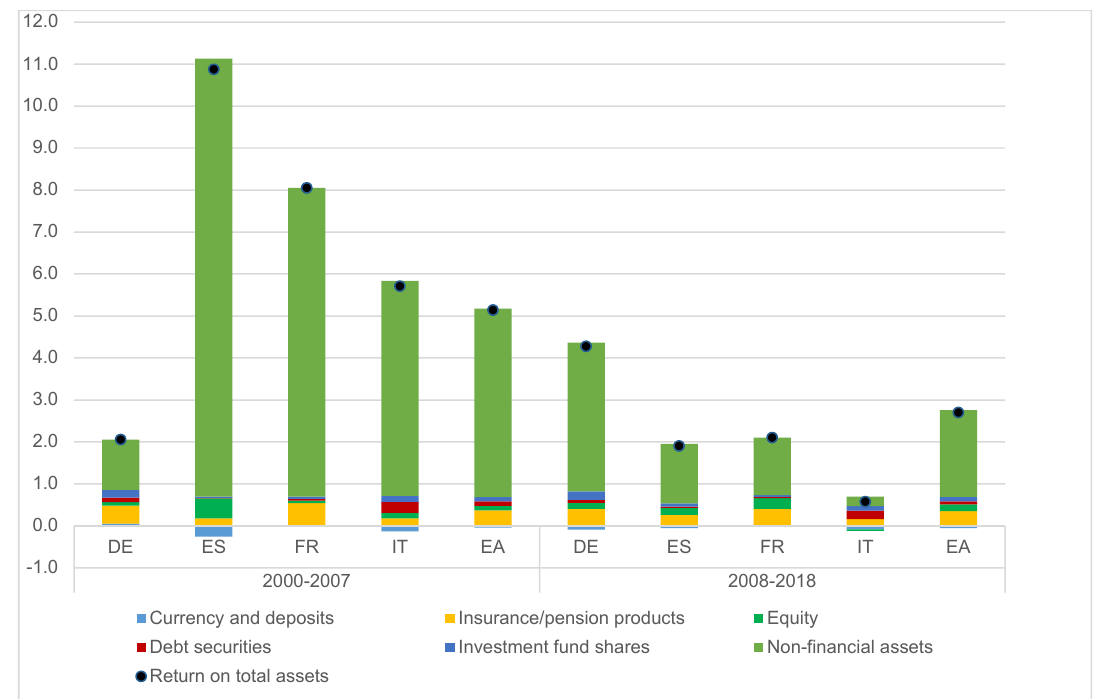
Figure 6. Contributions of individual assets to the real return on total assets (return on total assets in percent p.a., contributions of individual assets in percentage points). Notes: 1. DE: Germany; ES: Spain; FR: France; IT: Italy; EA: euro area; 2. The contribution of each asset to the real return on total assets represents the real return weighted by the respective portfolio share of total assets. The sum of the contributions of all assets is the total asset return. Source: authors’ calculations based on ECB, Eurostat, OECD, Thomson Reuters.